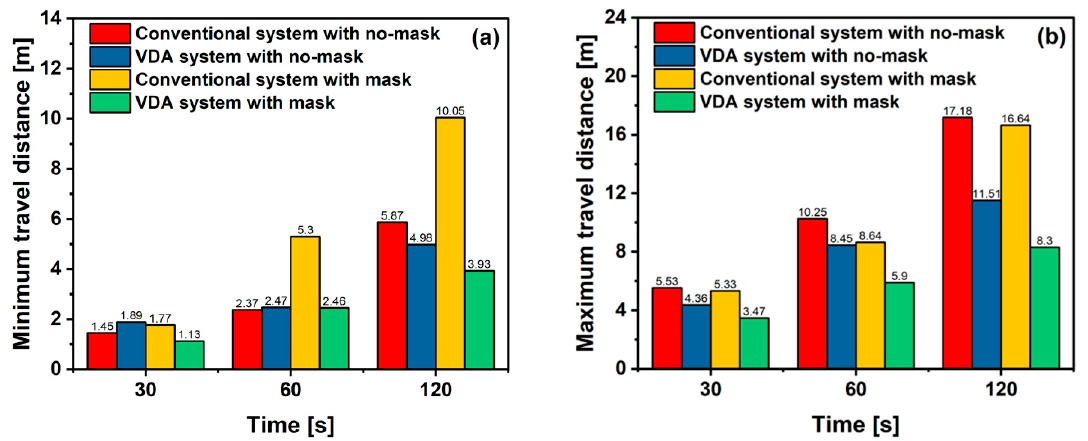
Figure 16. Variation in the ( a ) minimum and ( b ) maximum droplet travel distances in the conventional and VDA systems with and without the mask.